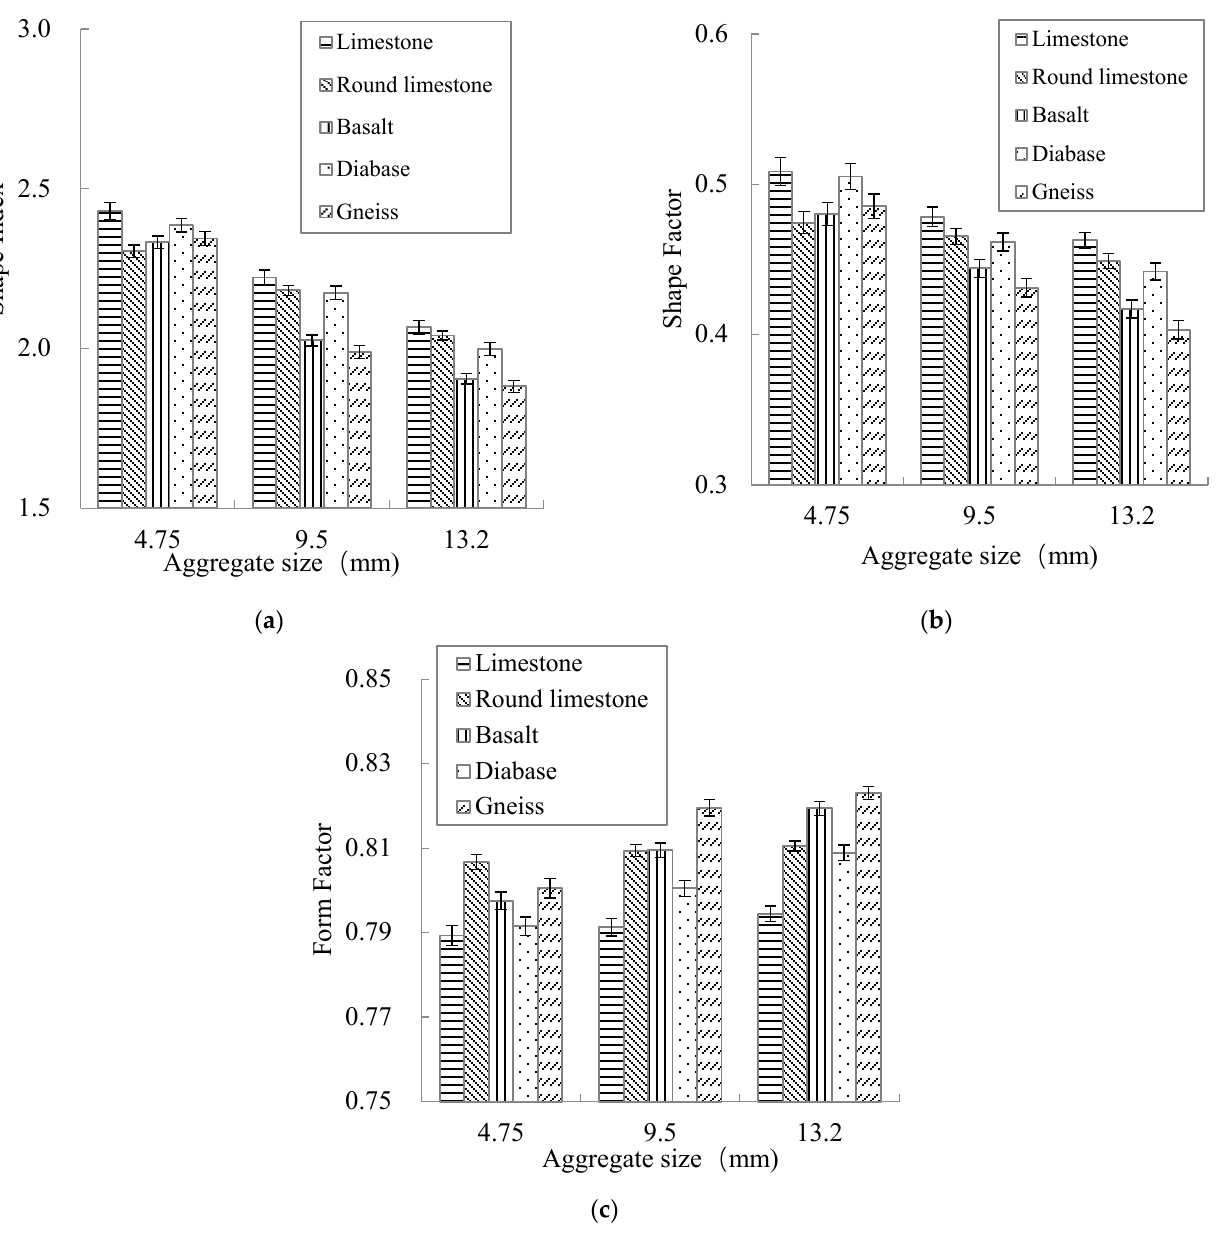
Figure 5. Test results of aggregate form properties: ( a ) Shape index, ( b ) Shape factor, ( c ) Form factor.